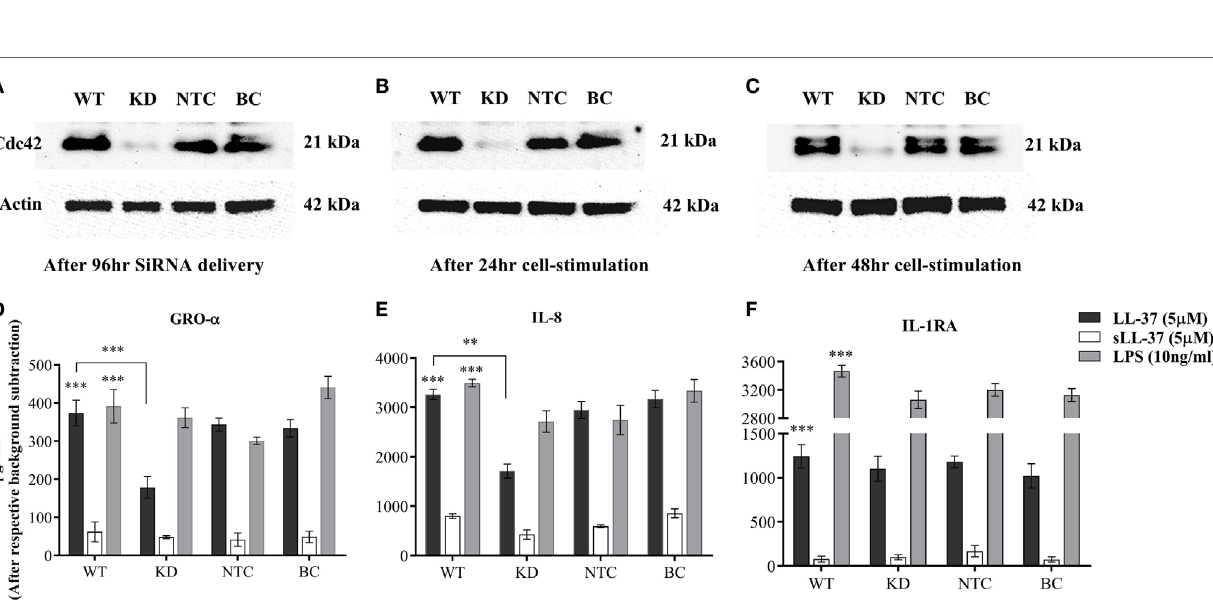
FigUre 7 | LL-37 activates Cdc42 Rho GTPase. Macrophage-like THP-1 cells were serum starved for 1 h prior to stimulation with either LL-37 (5 µM), sLL-37 (5 µM each), or lipopolysaccharide (10 ng/ml), and cell lysates collected after 5 min. The activities of (a) Cdc42 and (B) Rac1 Rho GTPases were determined using respective G-LISA assays. Positive control refers to active Cdc42 or Rac 1 protein provided in the G-LISA kit by the manufacturer. Results shown as mean ± SE of six independent experiments ( n = 6). Analysis of variance with Bonferroni’s post hoc test was used for statistical analyses (* p < 0.05, ** p <